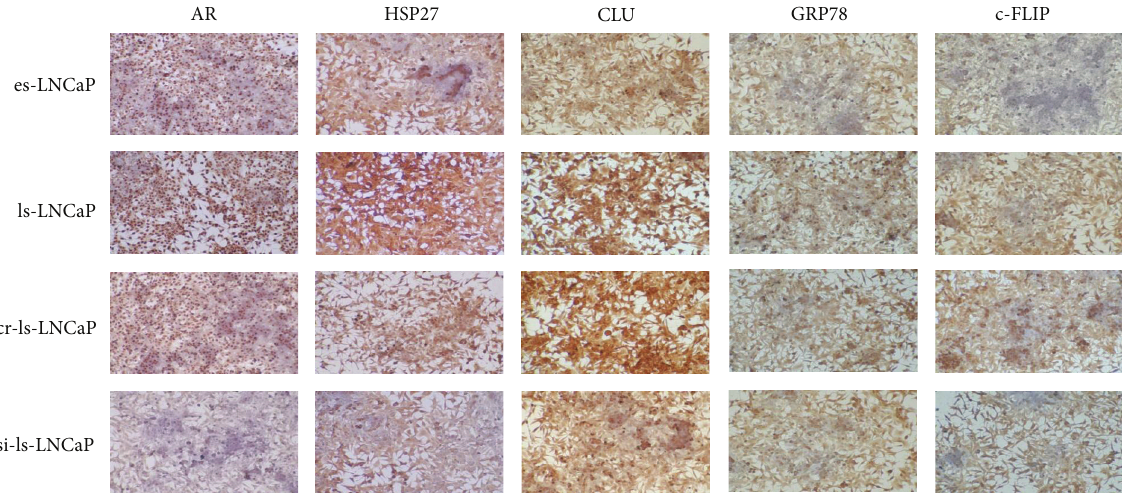
Figure 2: Immunocytochemical analysis of HSP27, clusterin, GRP78, and c-FLIP at the es-LNCap, ls-LNCap, scr-ls-LNCap, and si-ls-LNCaP cells.